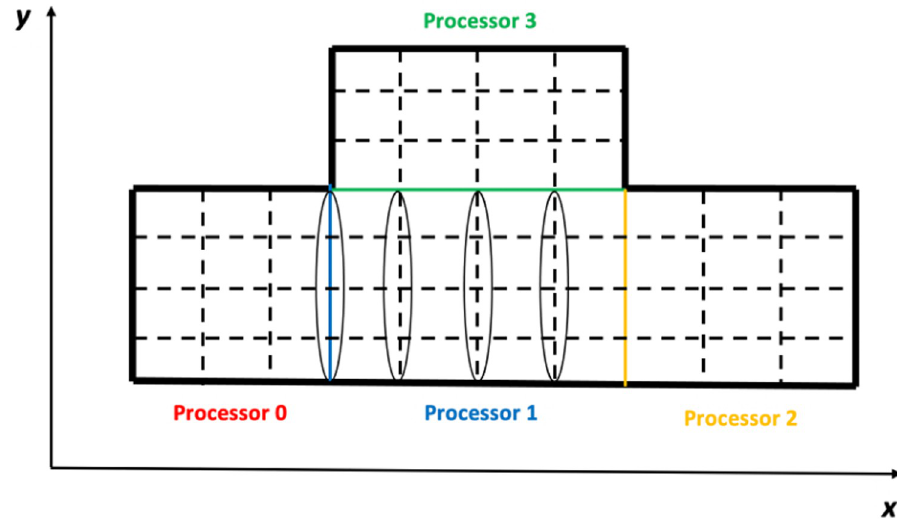
Fig 7. For the discretization pattern “xxlap”, the positions of the AEs on the subdomain of Processor 1 are surrounded by the four circles.